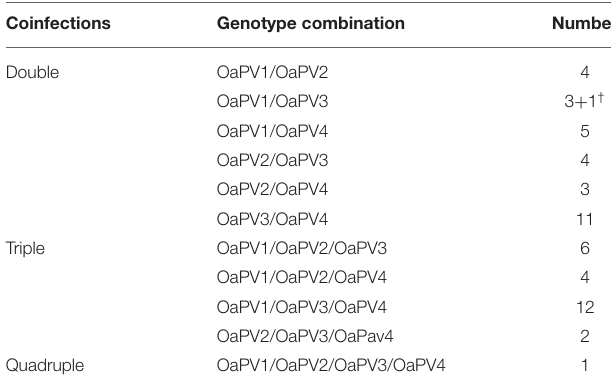
TABLE 3 | Genotype coinfections by ddPCR with related number of their combination are